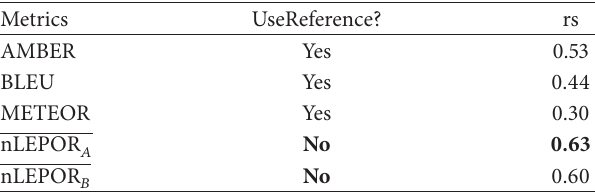
Table 3: Performances on the WMT12 testing